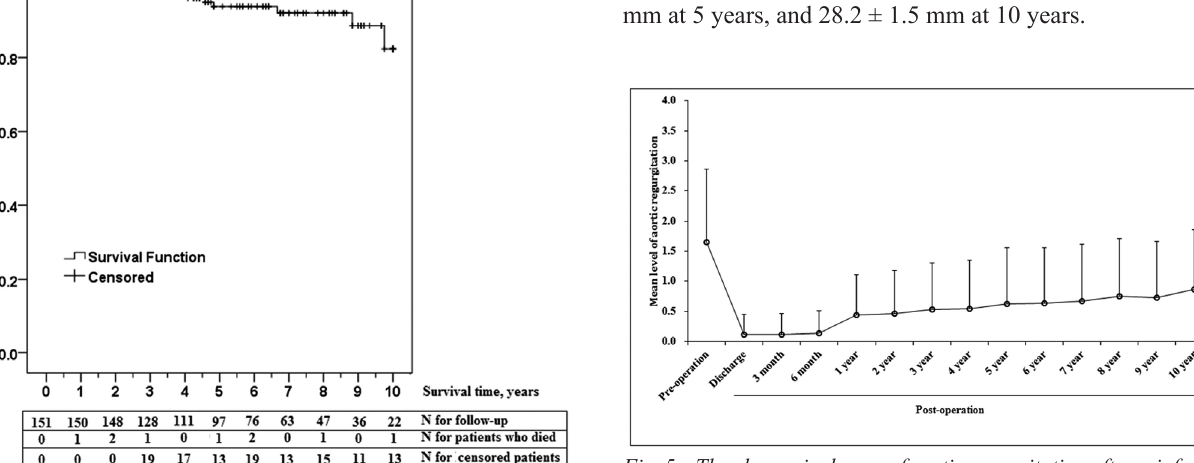
Fig. 5 – The change in degree of aortic regurgitation after reinforced aortic root reconstruction for acute type A aortic dissection involving the aortic root. Data are presented as the mean level of